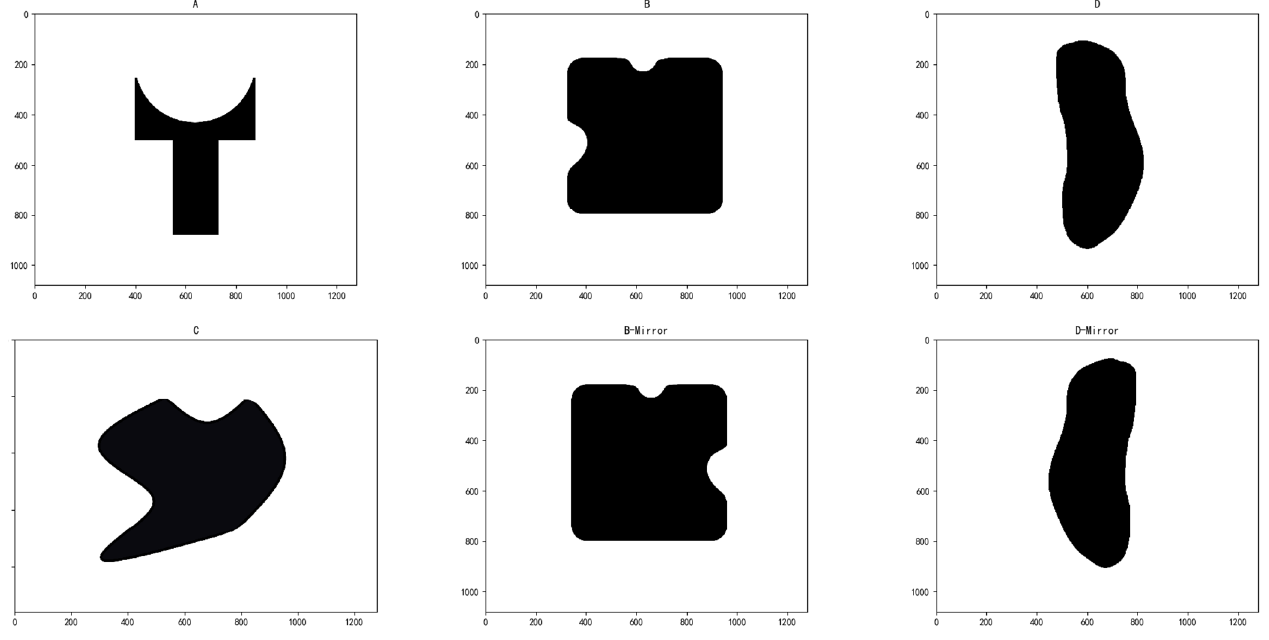
Figure 1. Template shaped workpiece. A–D are different types of artifacts, B-mirror is the mirror image of B, and D-mirror is the mirror image of D. Table 1. Base feature vectors for template shaped workpieces.